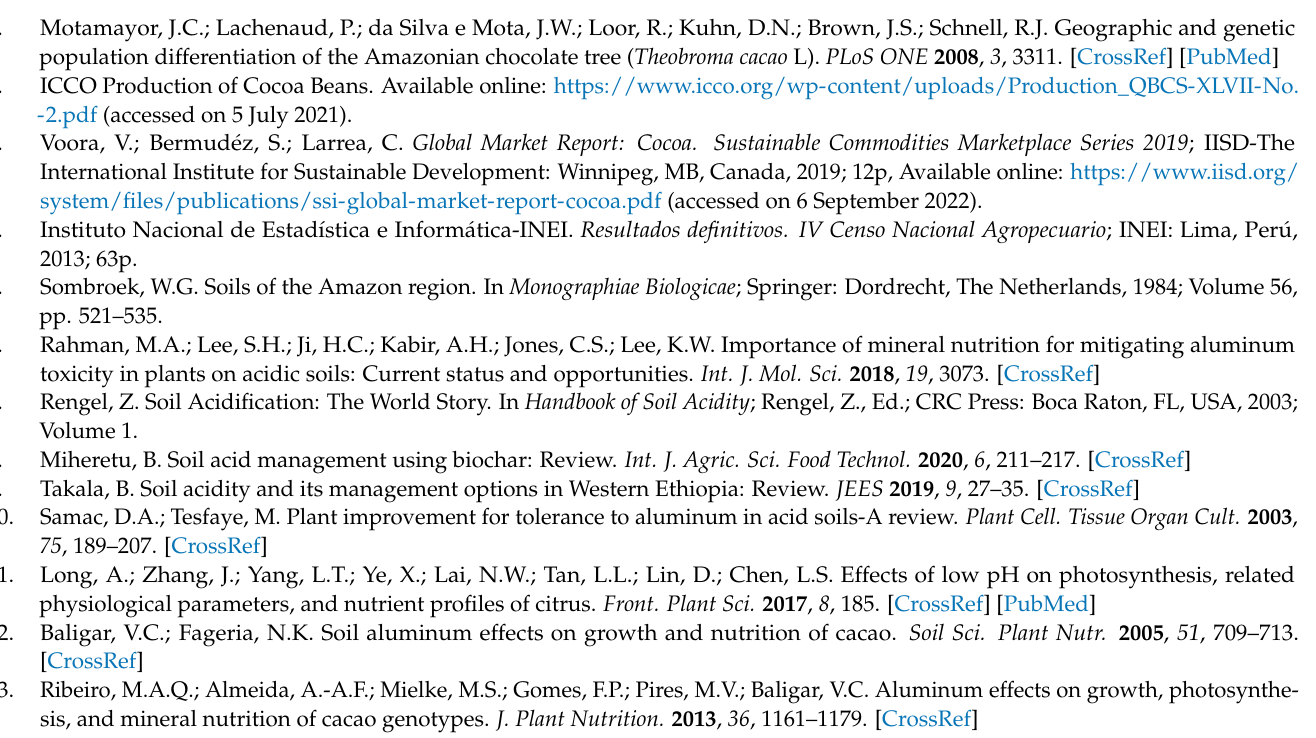
assessed. Table S3. Results of acid tolerance index (ATI), corrected acidity tolerance index